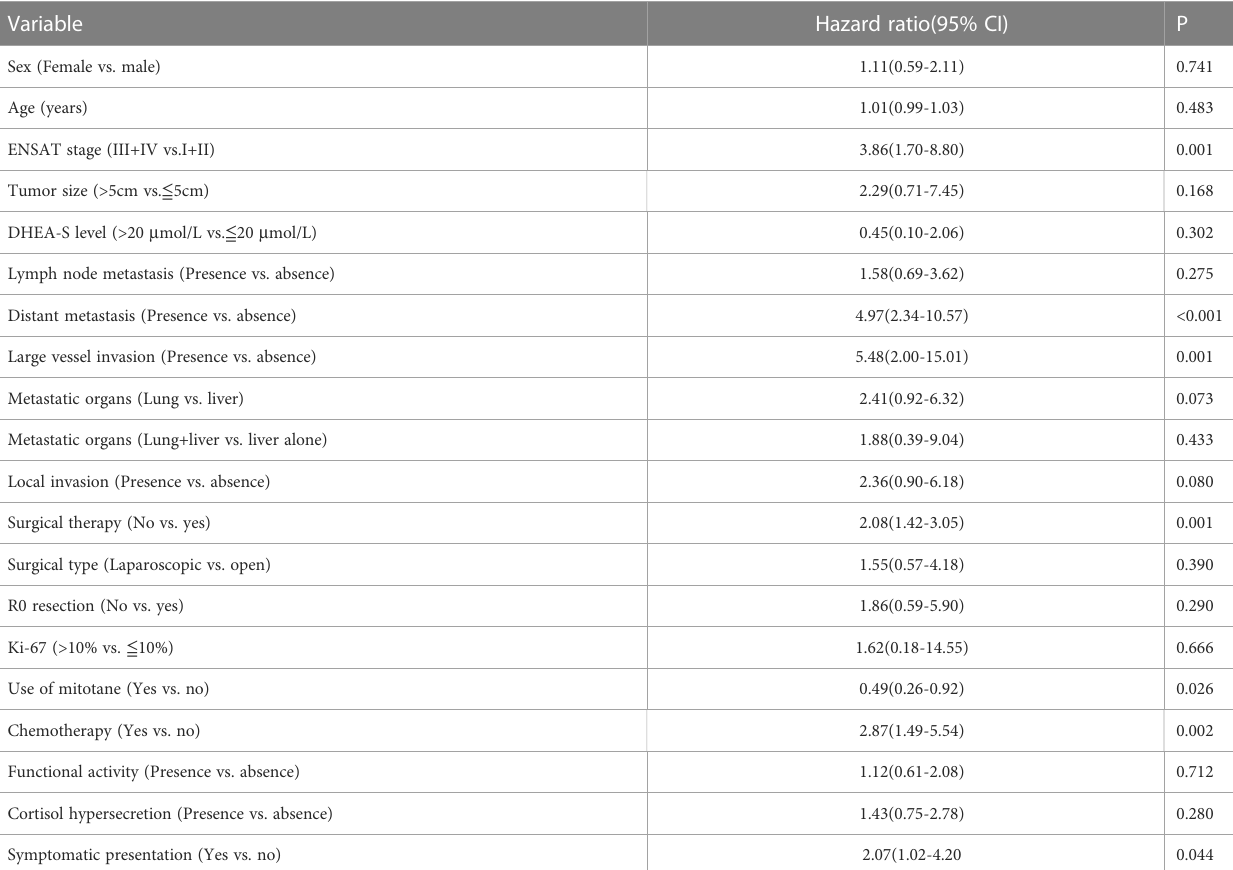
TABLE 2 Univariate Cox regression analysis on overall survival. Variable